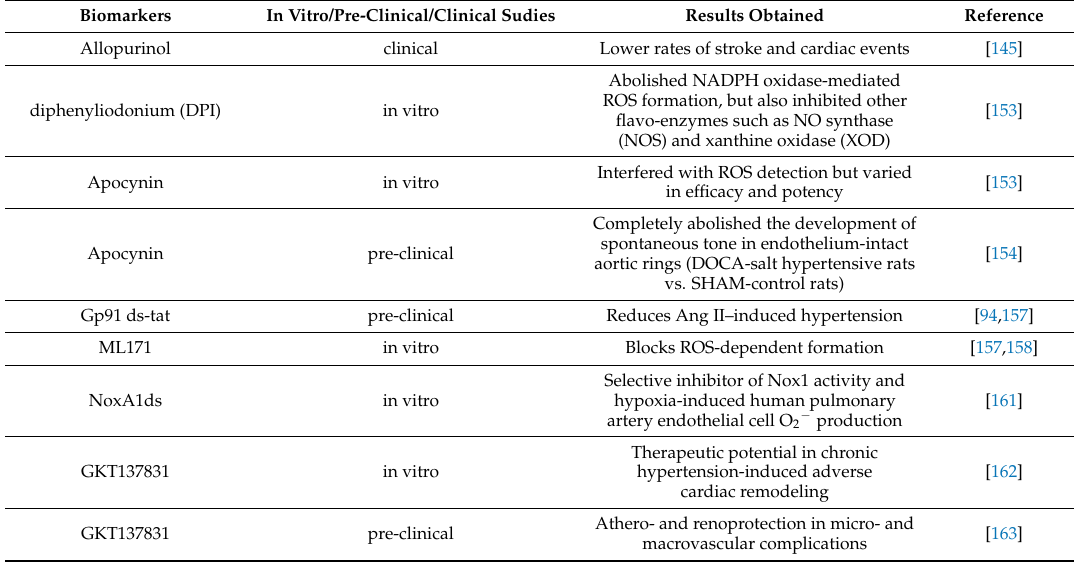
Table 1. Data on novel XO and NOX inhibitors as